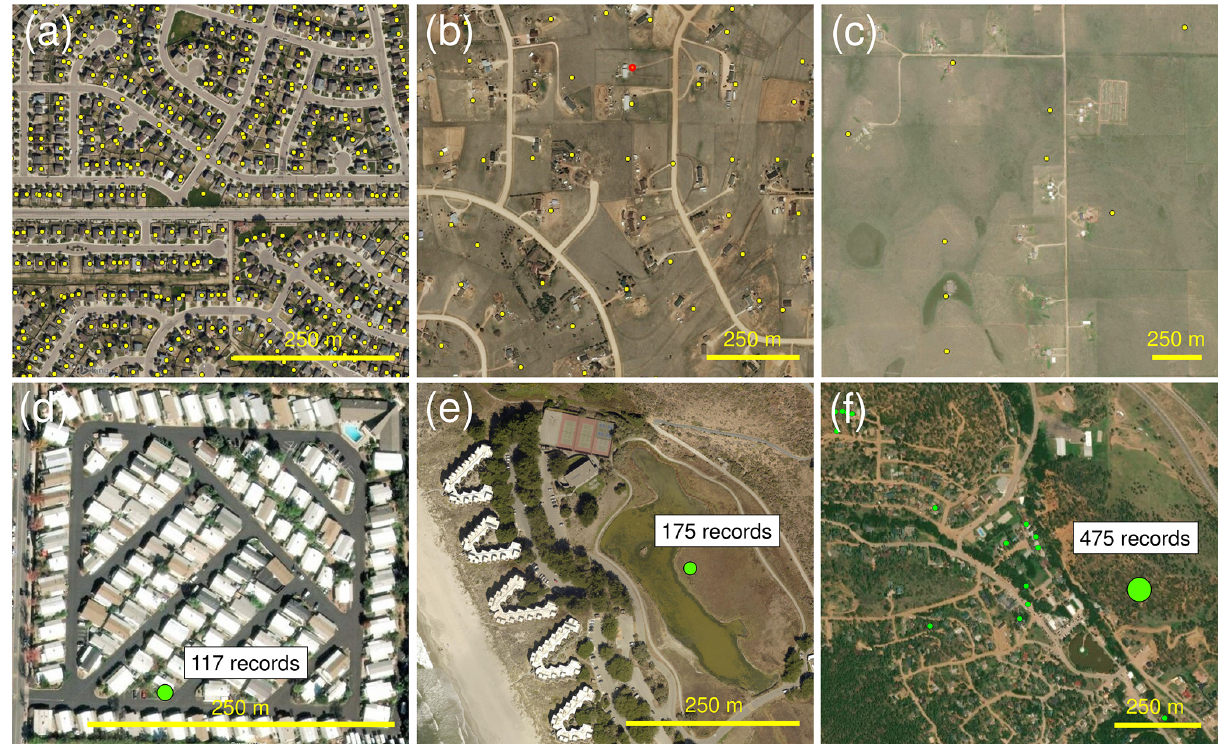
Figure 7. Variations in positional accuracy and generalization levels in the ZTRAX database: example of (a) highly accurate settlement locations in a dense residential neighbourhood dominated by single-family homes, (b) settlement locations of medium positional accuracy, and (c) settlement locations of low positional accuracy in rural parts of the USA. Spatially generalized settlement locations (i.e. multi-record locations) for (d) a mobile home park and (e) a planned community or condominium; (f) a rare agglomeration of records, likely resulting from pseudo-locations assigned during database work in progress. Base map imagery from © Microsoft